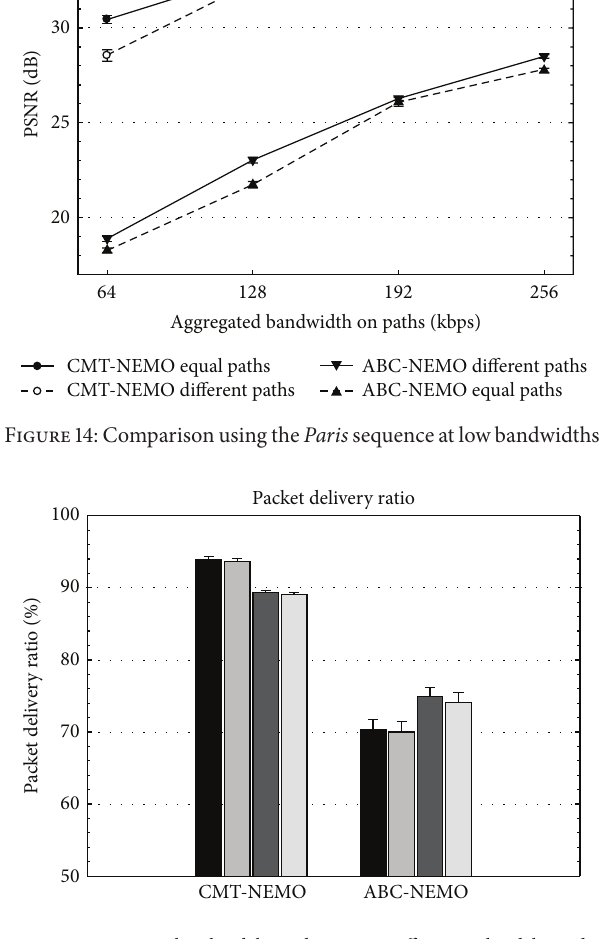
In ABC-NEMO, the path switching frequency is better controlled for differential path situations than for equal path scenarios. Path switching only takes place if the current (last used path) can no longer deliver packets within their decoding deadline.